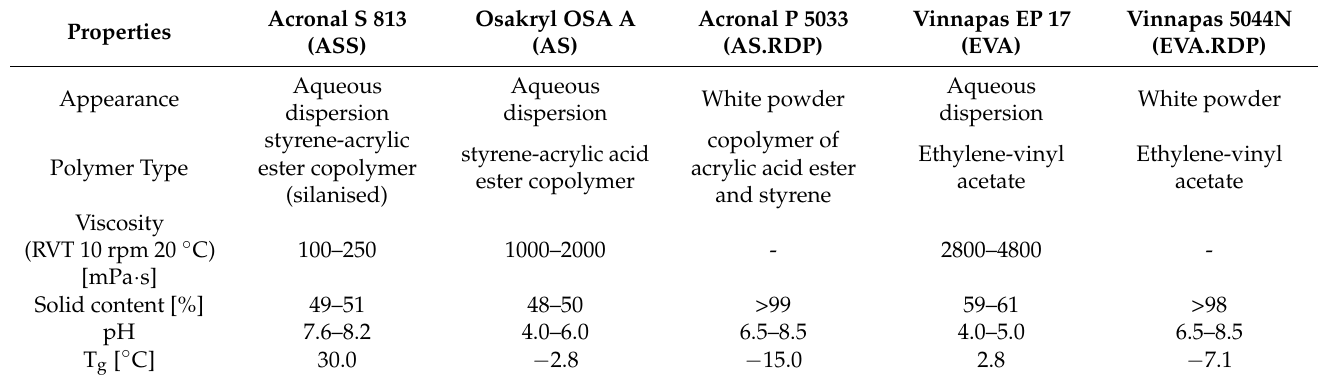
Table 3. Chemical and physical properties of polymer additives.